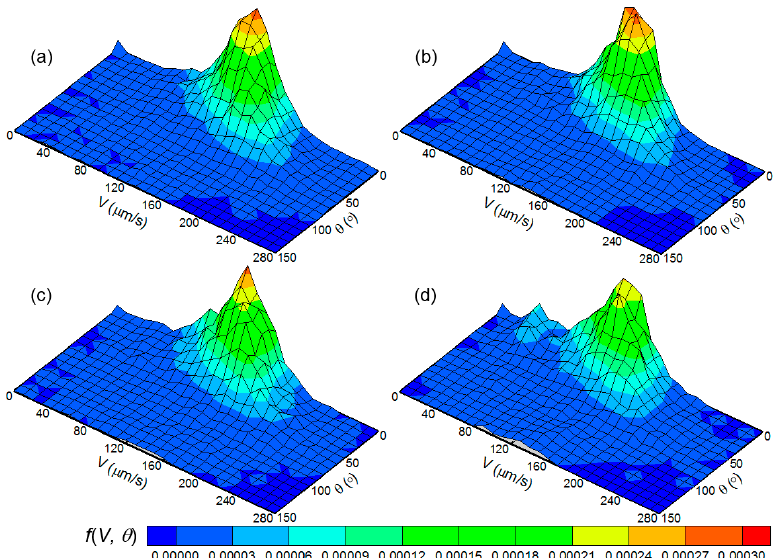
Figure 10. f ( V, θ ) at ( a ) 25 min, ( b ) 35 min, ( c ) 45 min, ( d ) 55 min.